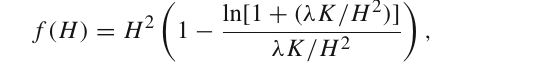
where, using S BH = K / H 2 given by Eq. (7), the extra driving term f ( H ) is written as